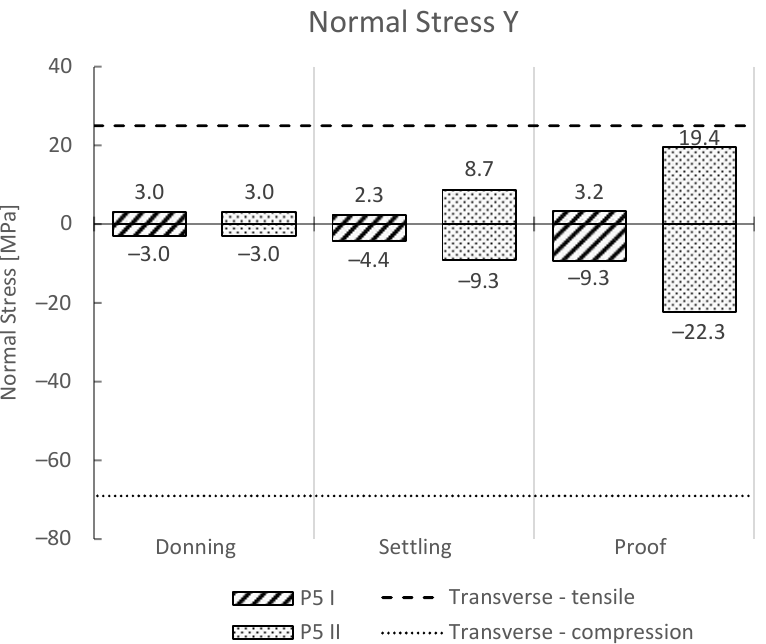
tests for transversely 3D-printed PLA samples were added to the plots.